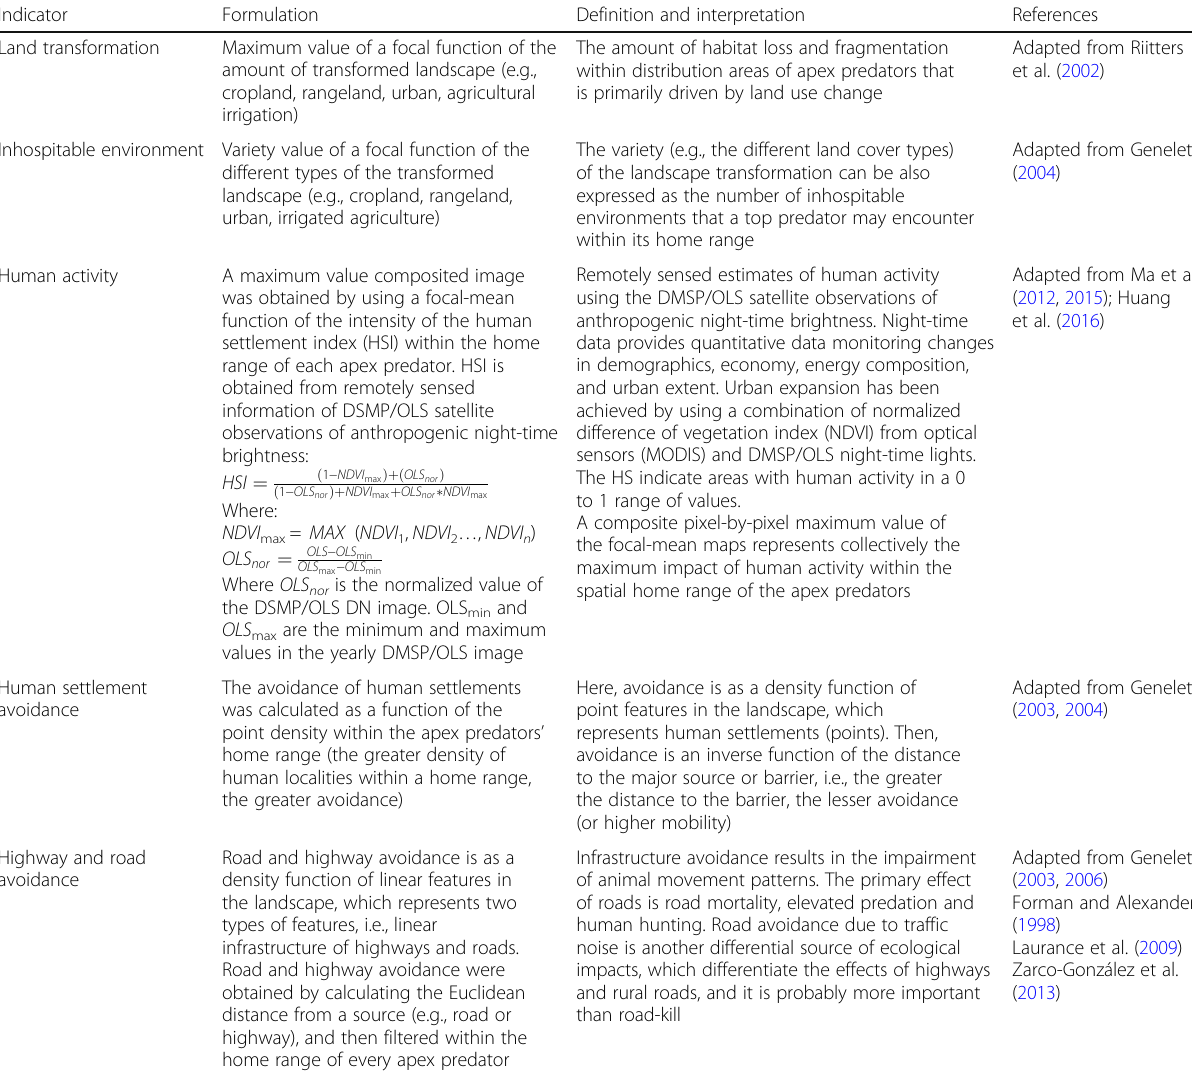
Table 1 Spatial impact indicators calculated to evaluate anthropogenic impacts in